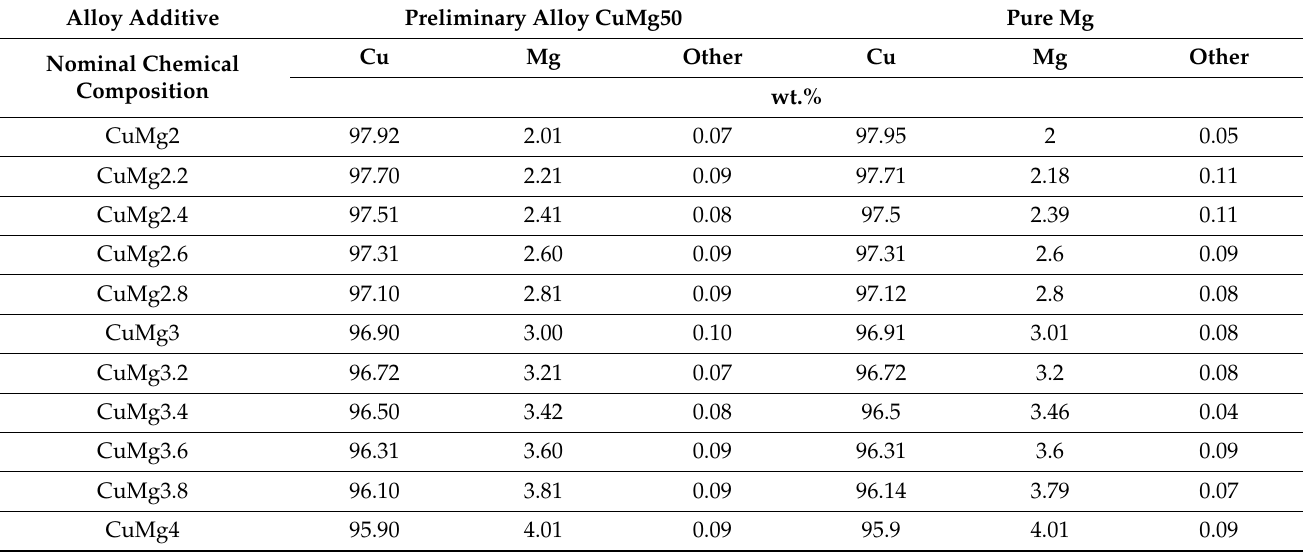
Table 1. Chemical compositions of the obtained